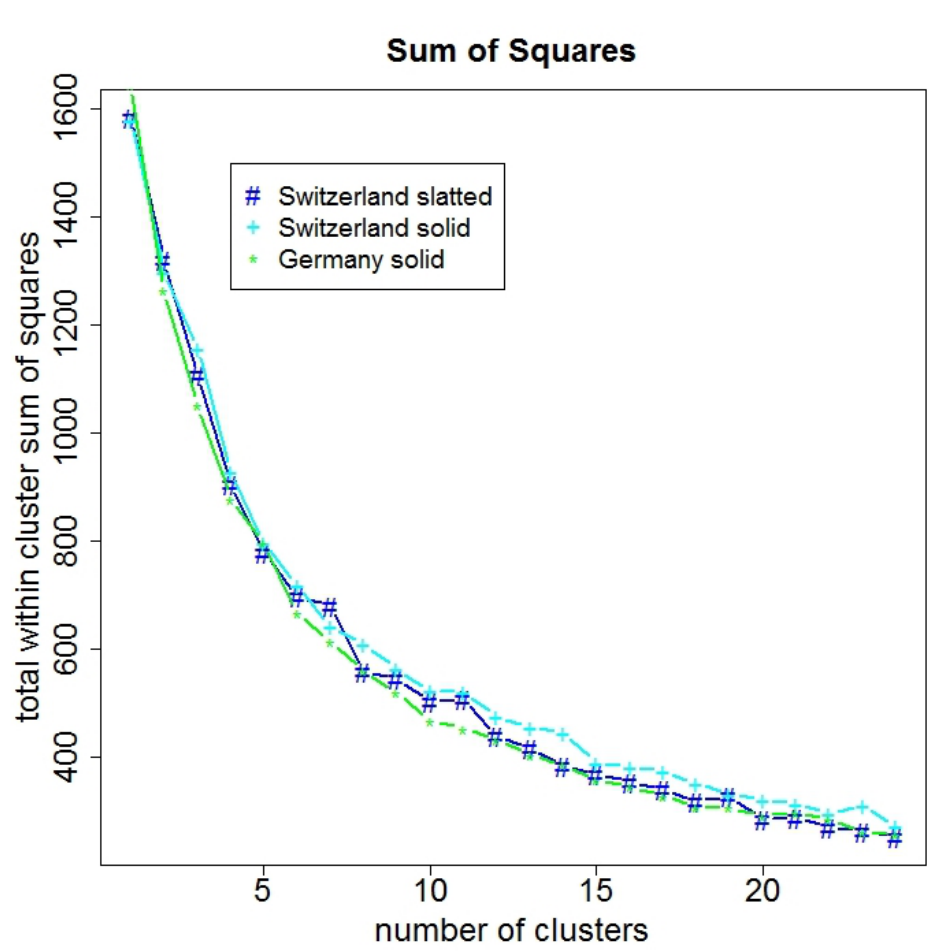
Figure 3. Clustering of normalized sets of environmental variables and CH 4 concentration and emission. Variation of the total sum of squares within the clusters depending on the number of clusters using the k-means algorithm for all three data